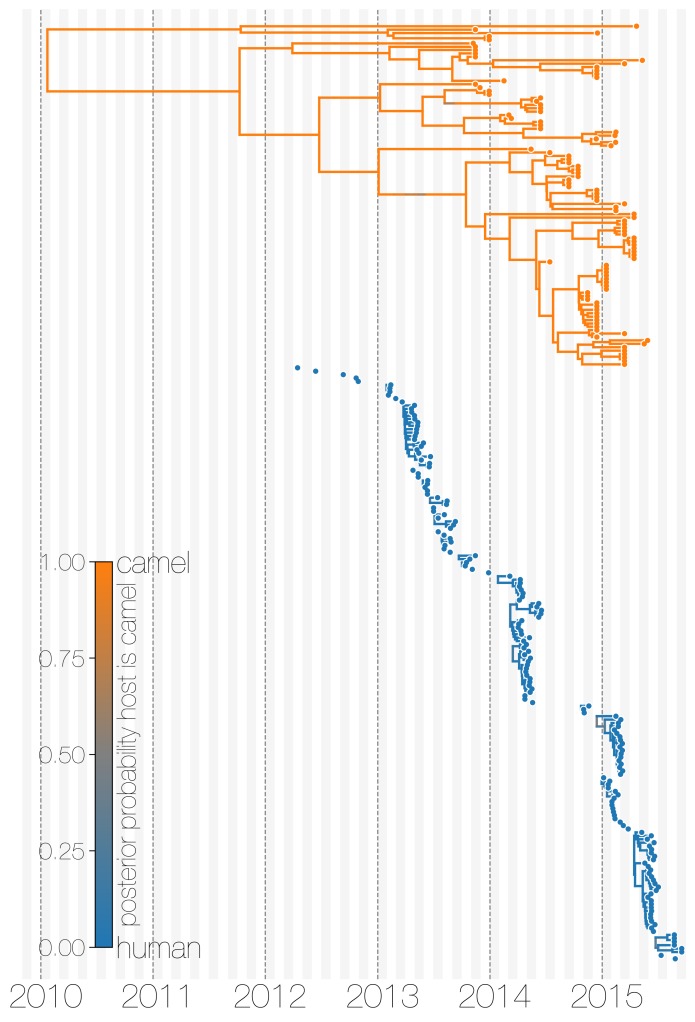
Evolutionary history of MERS-CoV partitioned between camels and humans.This is the same tree as shown in Figure 1, but with contiguous stretches of MERS-CoV evolutionary history split by inferred host: camels (top in orange) and humans (bottom in blue). This visualisation highlights the ephemeral nature of MERS-CoV outbreaks in humans, compared to continuous circulation of the virus in camels.